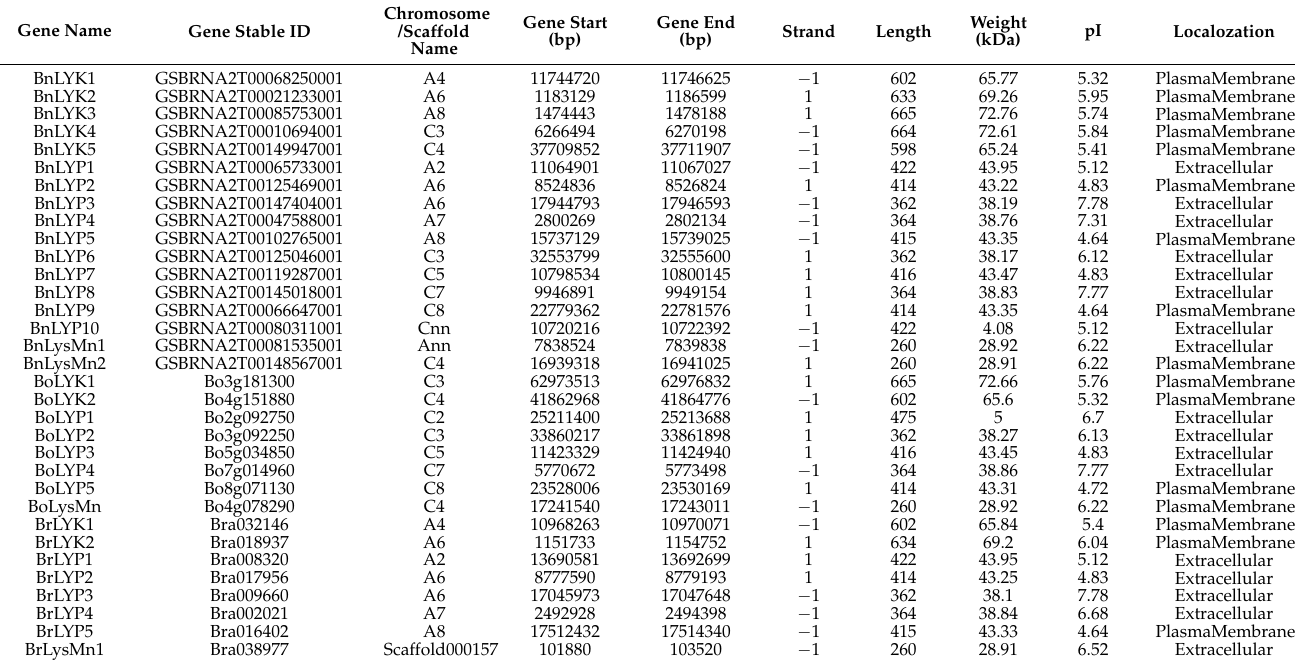
Table 1. Features of Brassica LysM-RLK